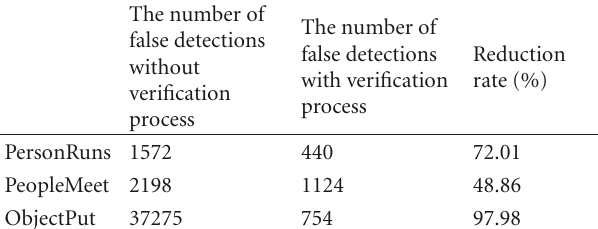
Table 2: Comparison of two methods. Table 3: Occurrence of false